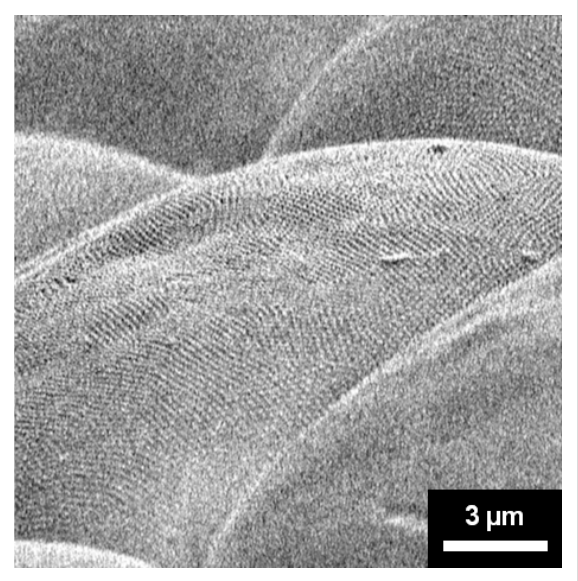
Figure 7: Extended Σ 13 coincidence site lattice covering several crys- tals (magnification: 13,000×).